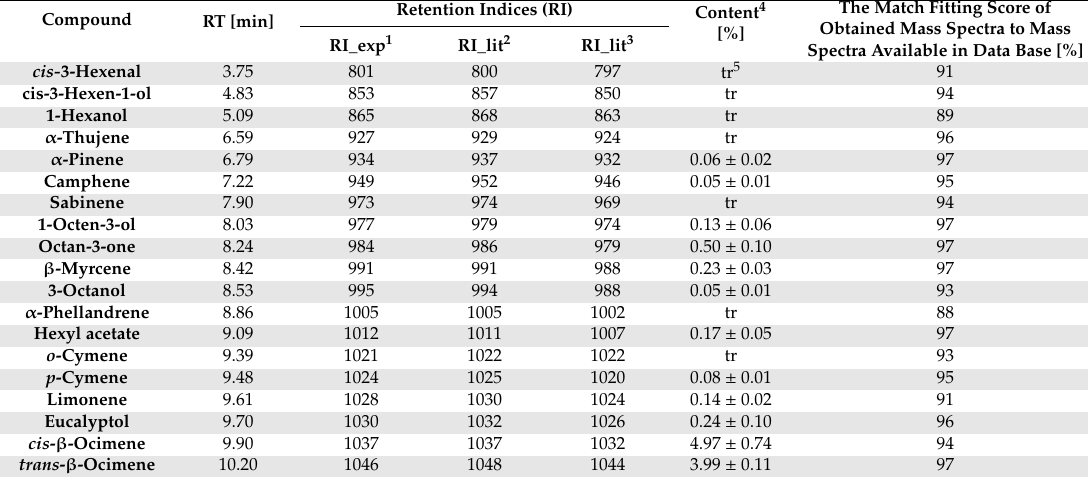
Table 2. Volatile profile determined by HS, solid-phase microextraction (HS-SPME) of true lavender flowers cultivated in